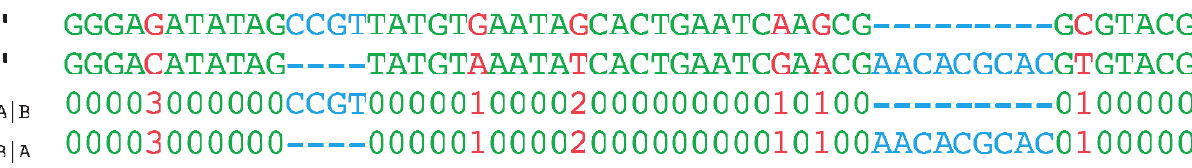
Figure 1. Example of an alignment and of the two translation strings T A D B and T B D A . Colors indicate sites with mutations (red), gaps (blue), and conservation